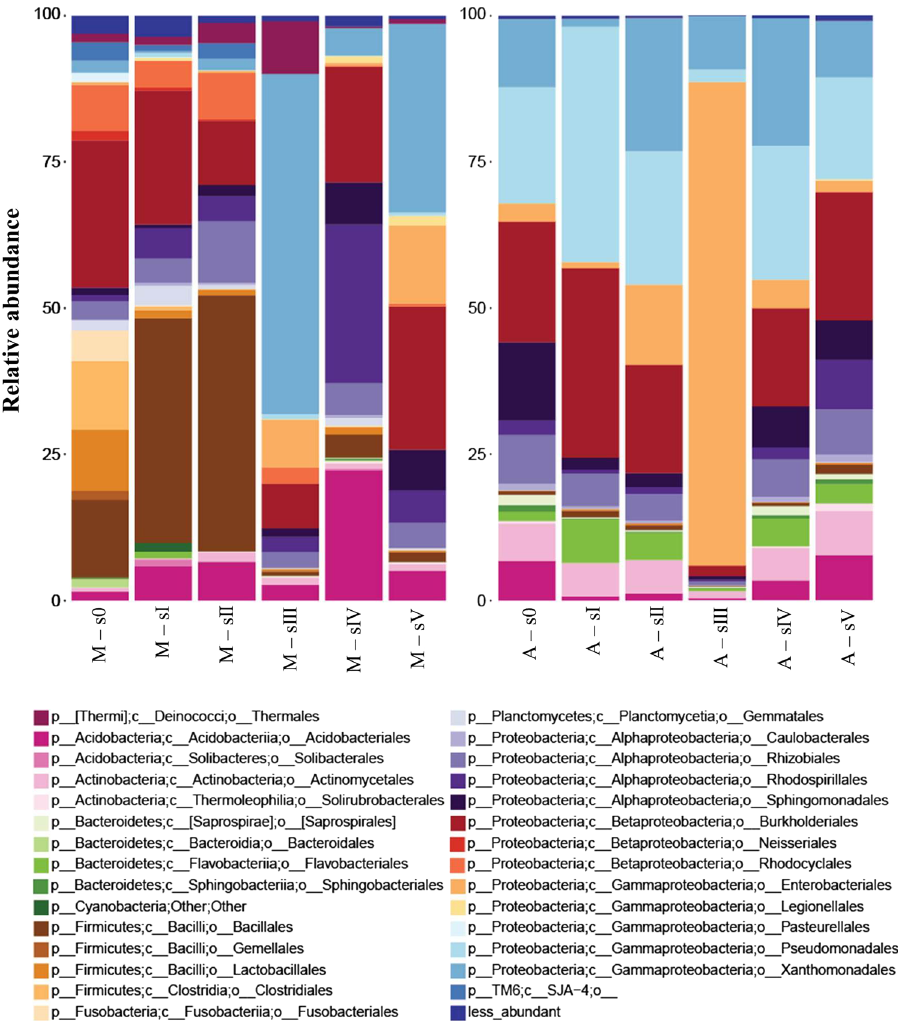
Figure 3. Diversity of endophytic, wood colonizing bacterial communities at the level of classes from pine trees of six different symptomatic classes from the two sampling areas (A and M) based on sequencing of PCR amplified 16S rRNA gene fragments. Only bacterial classes higher in abundance than 0.5% were